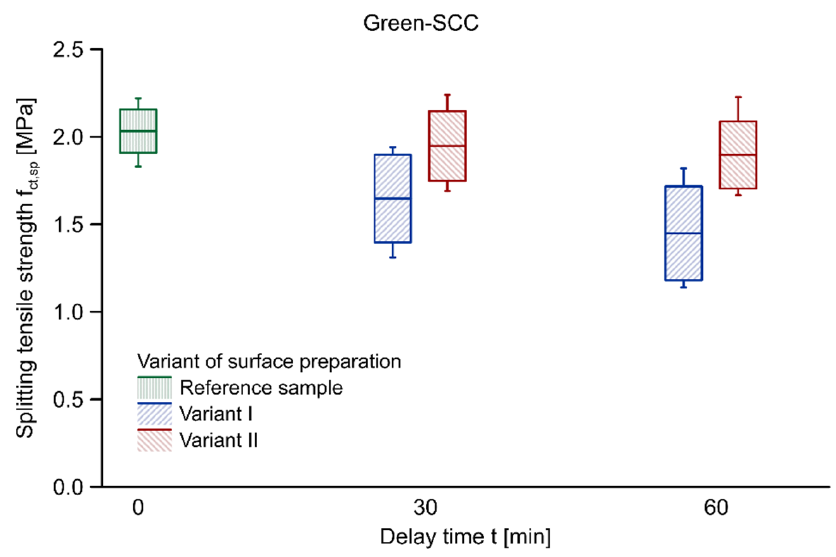
Figure 4. Splitting tensile strength vs. delay time between layers of Green-SCC concrete.